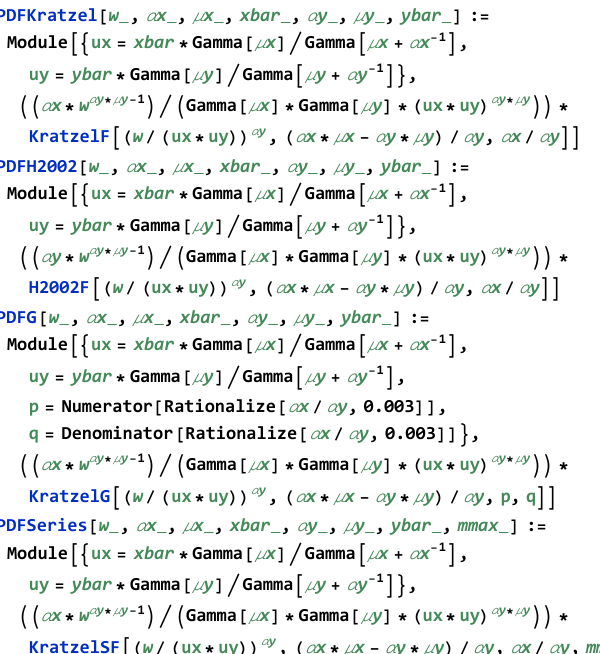
Figure 4. Algorithms used to implement the PDFs used in the present paper.